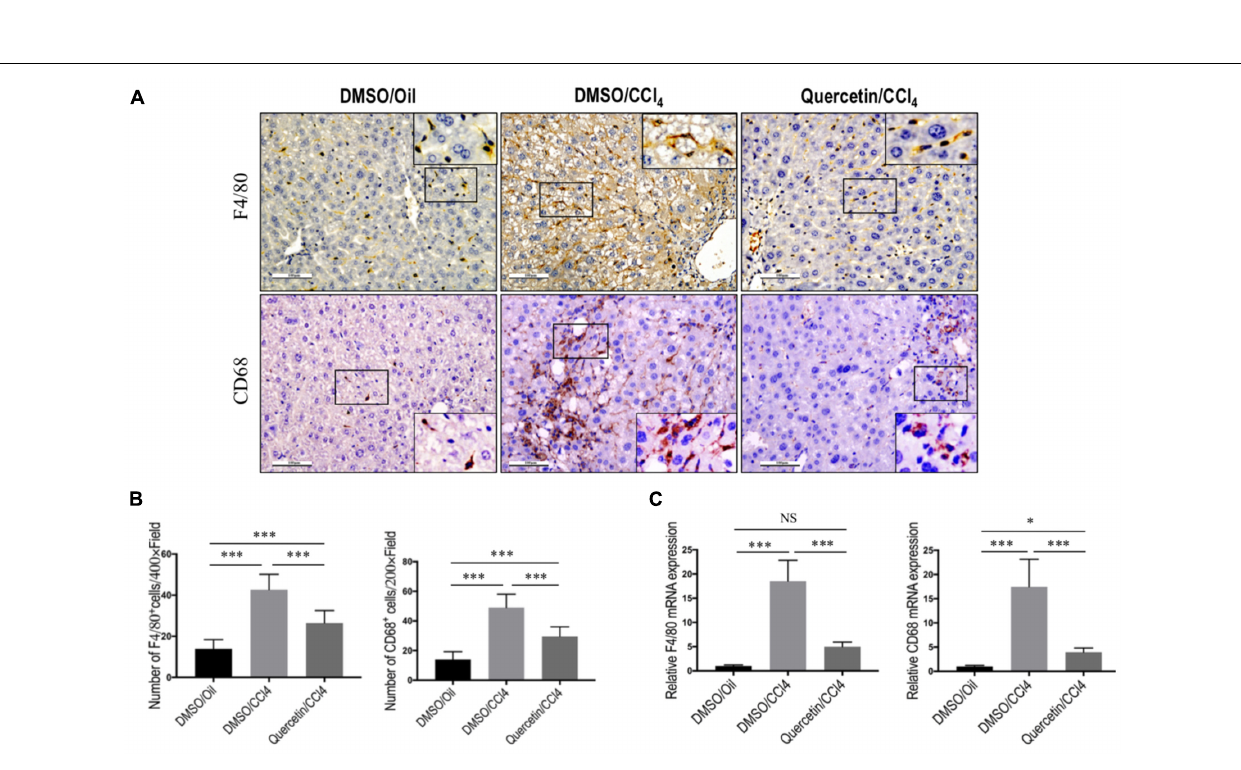
Frontiers in Pharmacology |